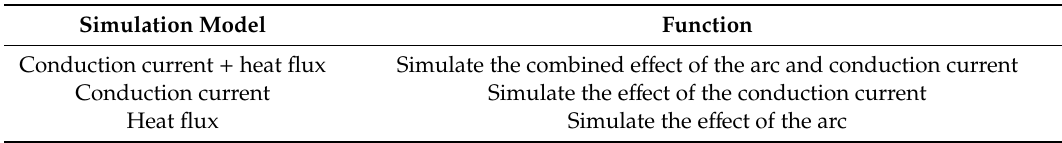
Table 3. Simulation